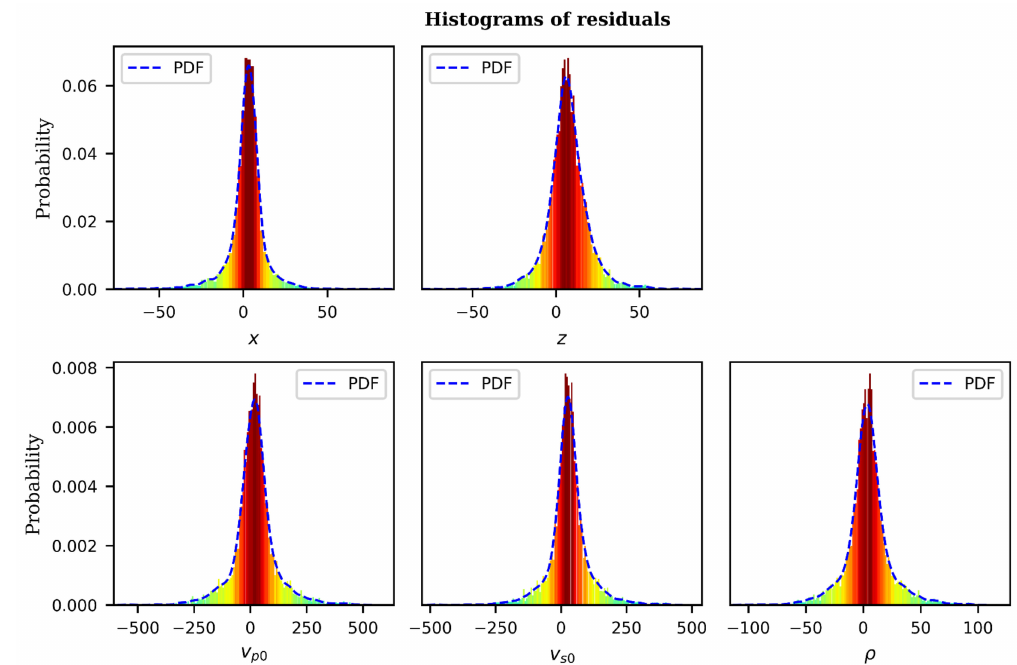
Figure 7. Residual diagnostic histograms for trained CNN model. The blue envelope represents the probability density function. The velocity model parameters of each histogram are indicated at the bottom center of each